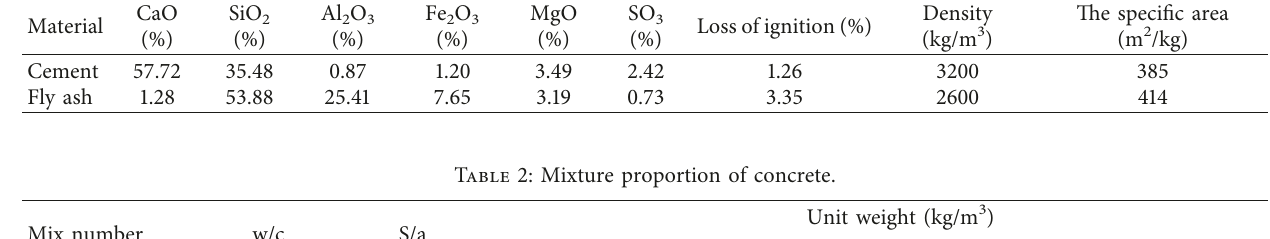
Table 1: Chemical composition and physical properties of the cementing materials.